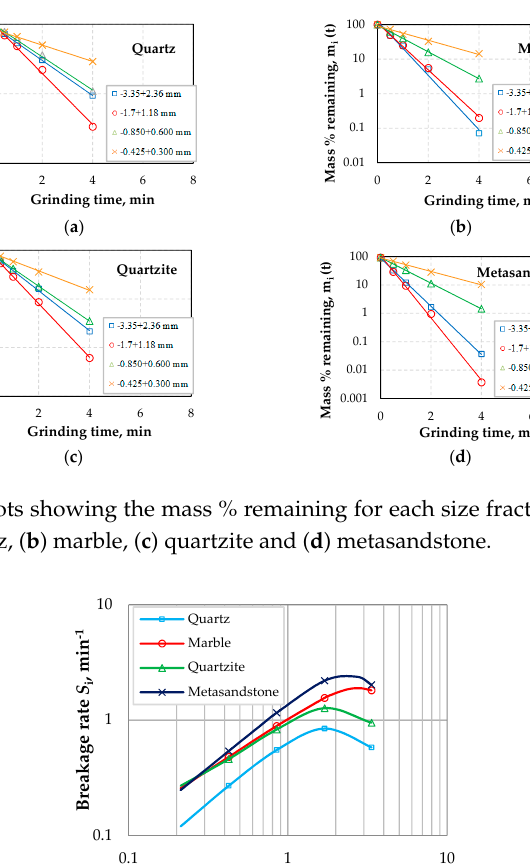
Figure 9. Variation of breakage rate S i vs. upper feed particle size. Table 5. Breakage rate parameters for all materials used.